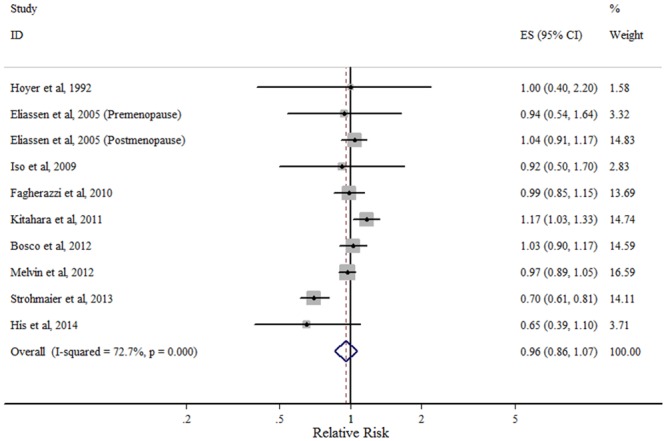
Forest plot of the highest vs. lowest categories of serum TC levels and breast cancer risk.Squares indicate study-specific relative risk estimates (size of the square reflects the study-specific statistical weight); horizontal lines indicate 95% confidence intervals (CI); diamond indicates the overall relative risk with its 95% confidence interval.